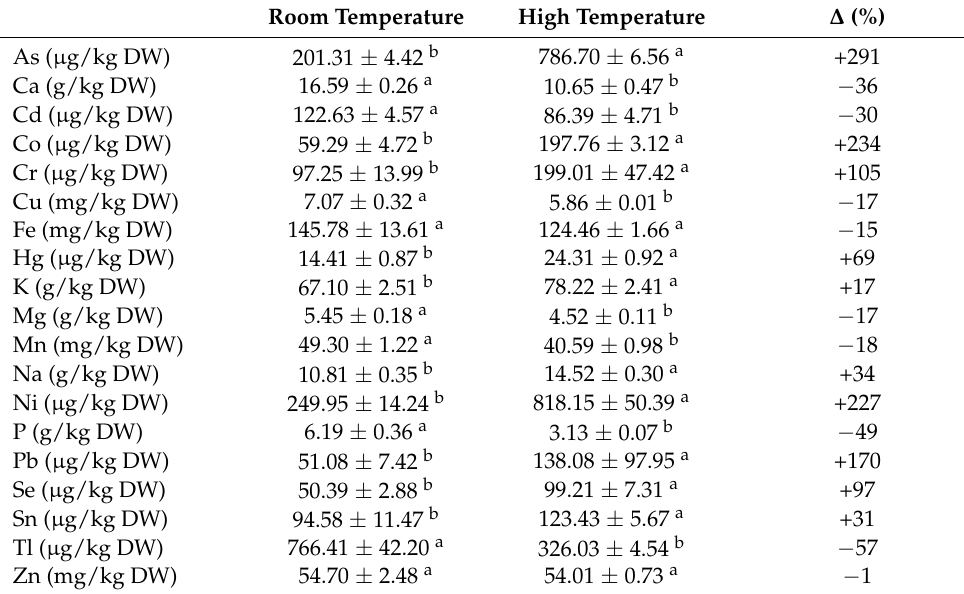
Table 4. Effect of high growing temperature on the concentration of macro- and microelements in broccoli